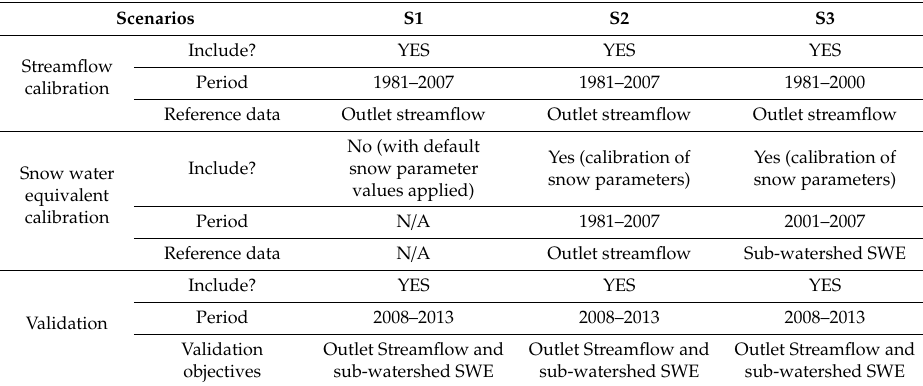
Table 3. Description of the three SWAT model calibration scenarios.